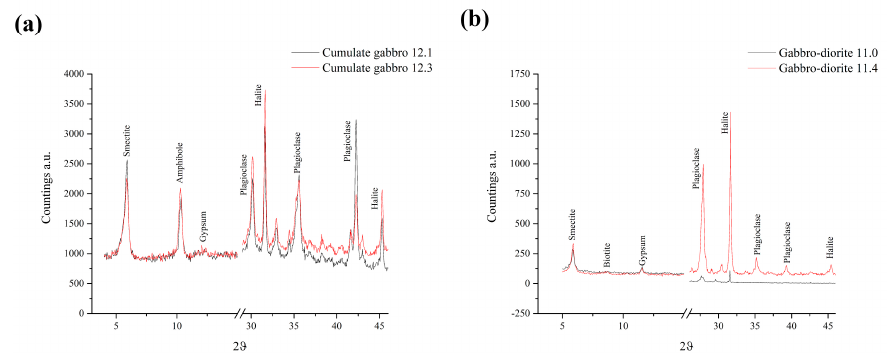
Figure 4. Di ff ractograms obtained through grazing apparatus on specimens after 64 days within brine: ( a ) cumulate gabbro; and ( b ) gabbro-diorite. For each we present di ff ractograms obtained at two distances, where the highest value is nearest the surface of the